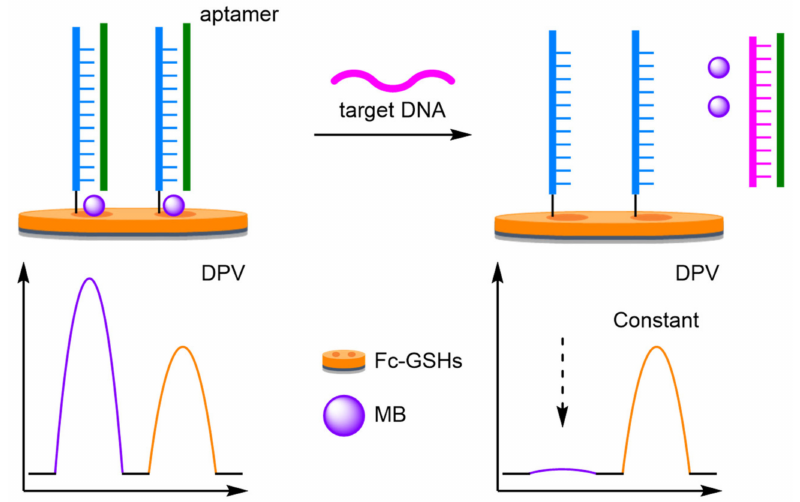
Figure 35. Schematic representation of a graphene-based modified